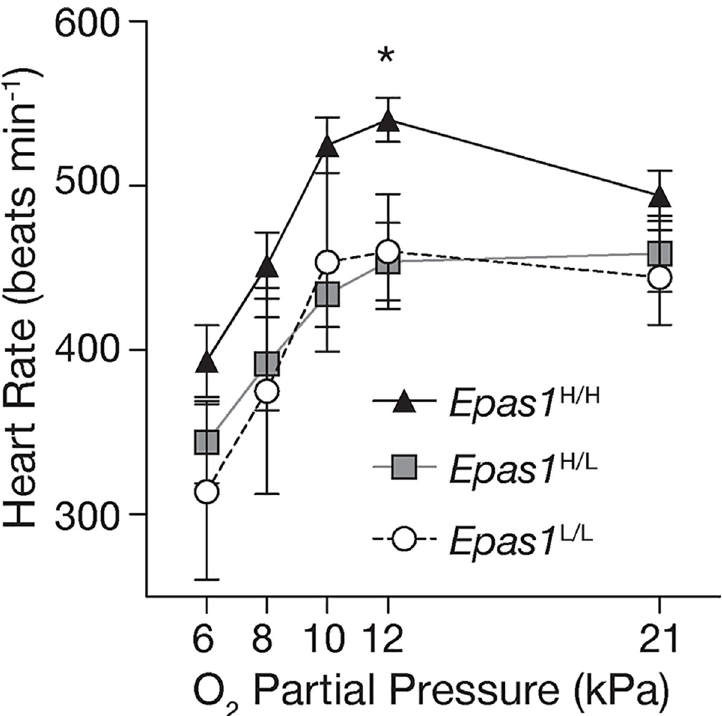
Fig 2. Deer mice that were homozygous for the highland Epas1 variant exhibited higher heart rates when exposed to environmentally realistic levels of hypoxia at 4300 m altitude (12 kPa O 2 ). Measurements were made using a MouseOx Plus collar. � Significant main effect of Epas1 genotype in a mixed linear model. n = 26 Epas1 H/H , n = 13 Epas1 H/L , and n = 4 Epas1 L/L